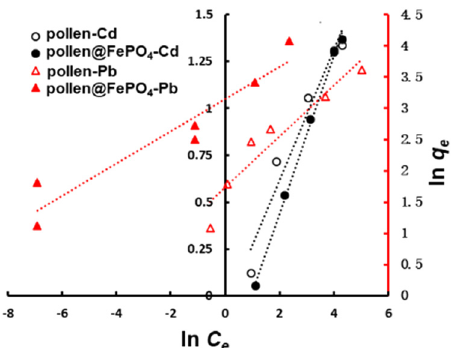
Figure 11: Freundlich isotherm plots of Cd 2 + /Pb 2 + on pollen@FePO 4 / pollen microspheres. Sample: 50 mL, initial pH 5.92; adsorbent dose 0.3278 g pollen@FePO 4 /pollen; contact time 60 min.